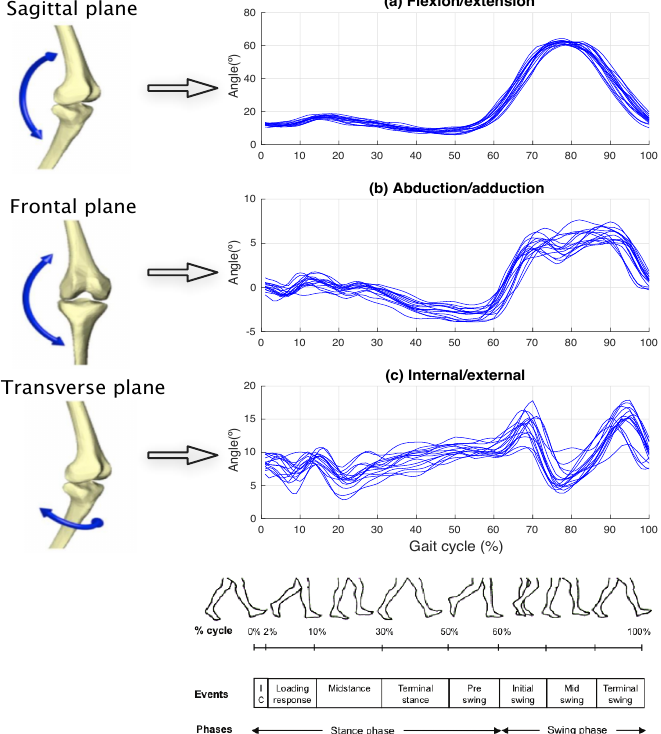
Figure 1. A family of twenty knee kinematic data curves measured for a particular participant: ( a ) flexion/extension, ( b ) abduction/adduction, and ( c ) internal/external rotation. Each curve was interpolated and re-sampled from 1% to 100% (100 points) of the gait cycle. Moreover, 1% corresponds to the initial contact (IC) and 100% to the end of the swing phase.